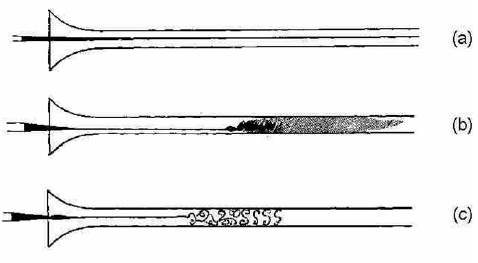
Figure 7: The original pictures by Reynolds which show the transition to a turbulent state of a flow in a pipe, as the Reynolds number increases from top to bottom (see the website Reynolds,